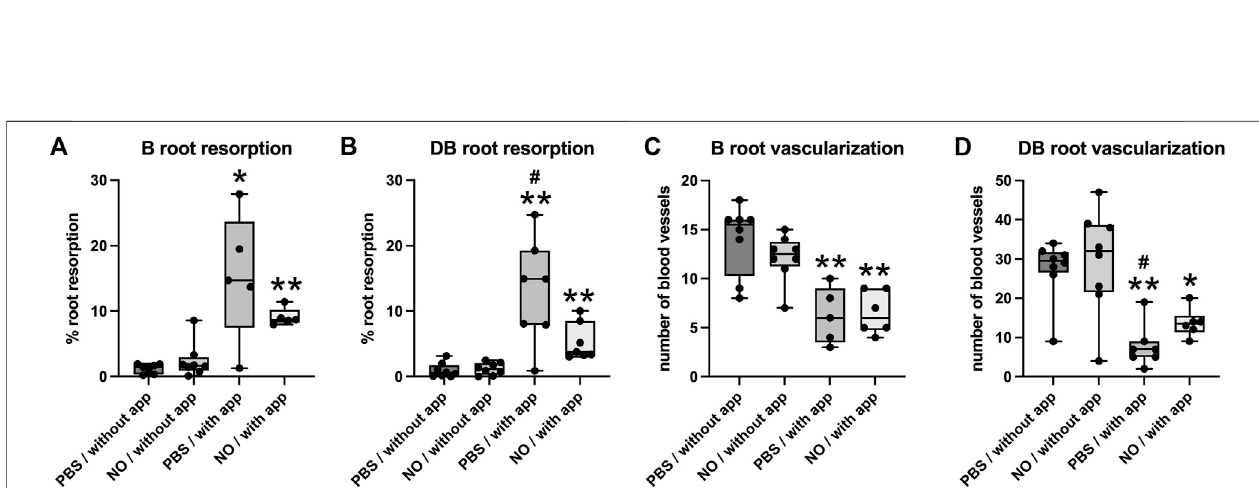
FIGURE7| HistomorphometryofrootresorptionandPDLvascularizationofthebuccalanddistobuccalrootsofthemaxillary fi rstmolarafter18 days±orthodontic tooth movement. Whisker plots showing medians, interquartile range, minimum and maximum values are shown. (A,B) Root resorption is signi fi cantly increased in animalsthatunderwenttoothmovementcomparedtothosethatdidnothaveorthodonticappliancesonbothbuccalanddistobuccalroots. (C,D) Bloodvesselnumbers inthePDLweresigni fi cantlydecreasedinanimalsthatunderwenttoothmovementcomparedtothosethatdidnothaveorthodonticappliancesonbothbuccaland distobuccalroots.Signi fi cantlylessrootresorptionwasseeninanimalsthatunderwenttoothmovementandreceivedinjectionsofNOreleasingnanoparticlescompared to animals that underwent tooth movement and received injections of saline for the distobuccal root (B) . Signi fi cantly more blood vessels were seen in animals that underwenttoothmovementandreceivedinjectionsofNOreleasingnanoparticlescomparedtoanimalsthatunderwenttoothmovementandreceivedinjectionsofsaline for the distobuccal root (D) . * p < 0.05 compared to group without tooth movement, ** p < 0.005 compared to group without tooth movement, # p < 0.05 compared to group that received nanoparticle injections. Without app = no orthodontic appliances/no orthodontic tooth movement, with app = with orthodontic appliances/with orthodontic tooth movement, PBS = phosphate buffered